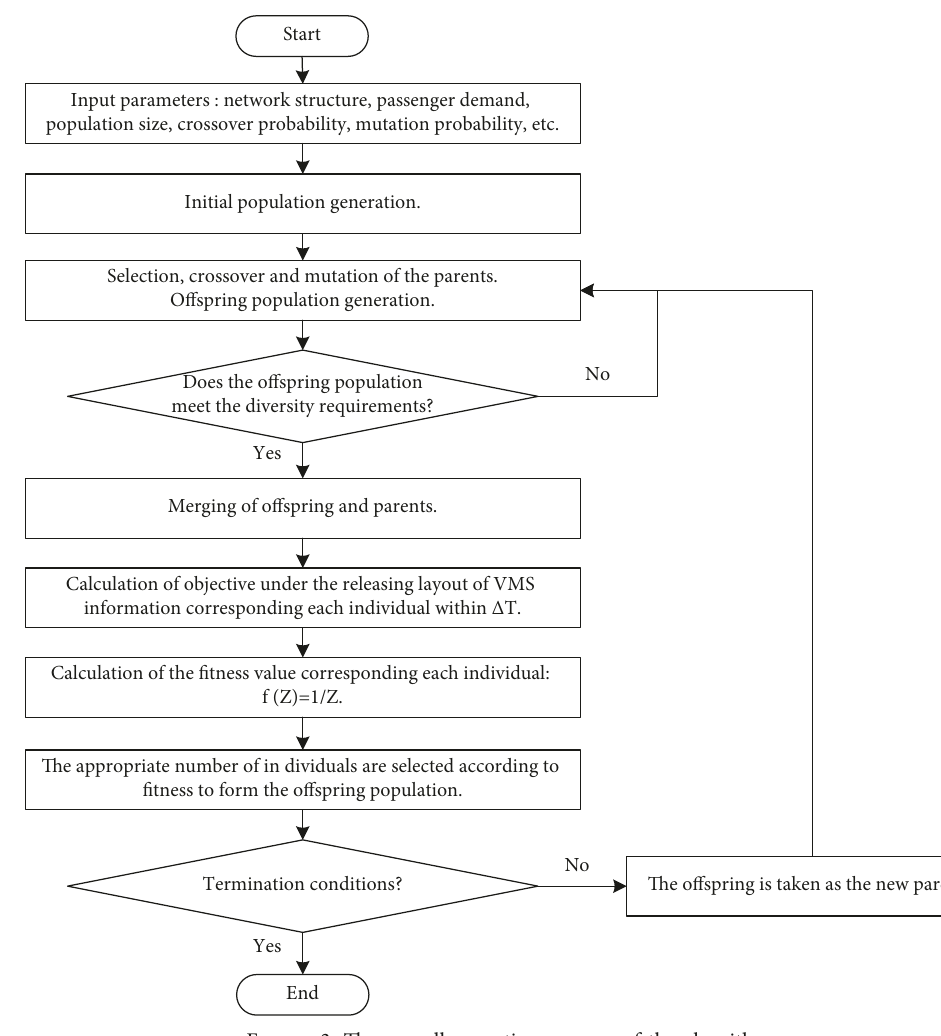
Figure 3: The overall execution process of the